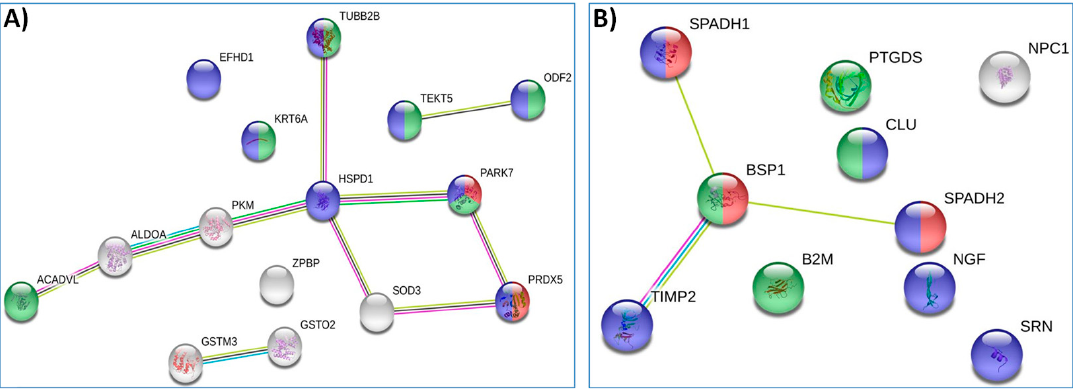
Figure 2. STRING analysis of identified bull thawed spermatozoa proteins ( A ) and supernatant ( B ). The proteins are connected with confidence network edges, indicating putative protein interactions.